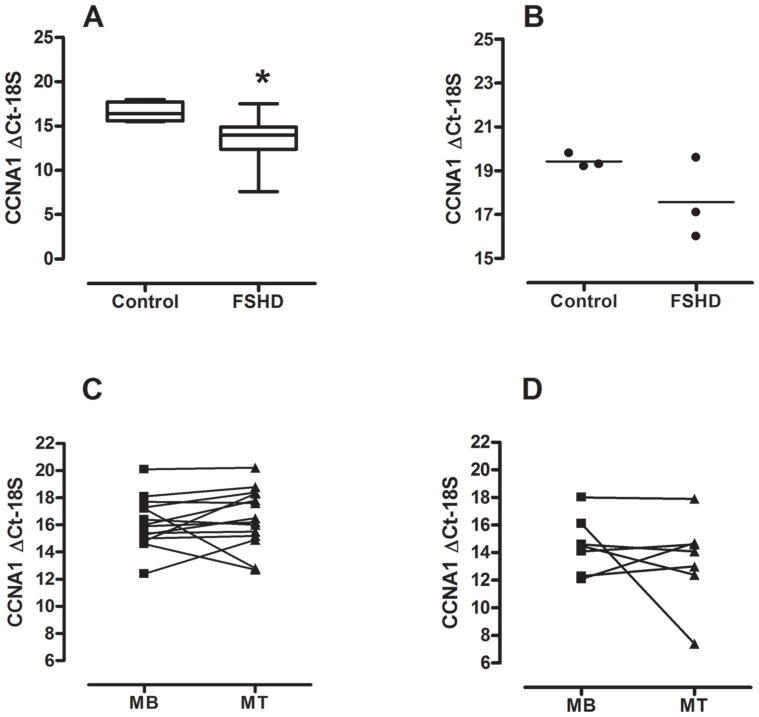
Cyclin A1 expression levels in FSHD (RT-PCR).(A) CCNA1 ΔCt-18S in myotubes derived from FSHD patients (n = 7) and age-matched healthy controls (n = 7), ΔΔCt = −3.2, n-fold change: 2−ΔΔCt = 9.2. Data are given as median, 25th and 75th percentiles and range. *) p<0.05; Mann-Whitney U-test; (B) CCNA1 ΔCt-18S in muscle tissue derived from FSHD patients (n = 3) and age-matched healthy controls (n = 3), ΔΔCt = −1.9, n-fold change: 2−ΔΔCt = 3.7. Data are given as single values; (C) CCNA1 ΔCt-18S in myoblasts (MB) and myotues (MT) from healthy controls (n = 14), ΔΔCt = 0.3. Data are given as median; (D) CCNA1 ΔCt-18S in MB and MT from FSHD patients (n = 7), ΔΔCt = 2.0. Data are given as median.